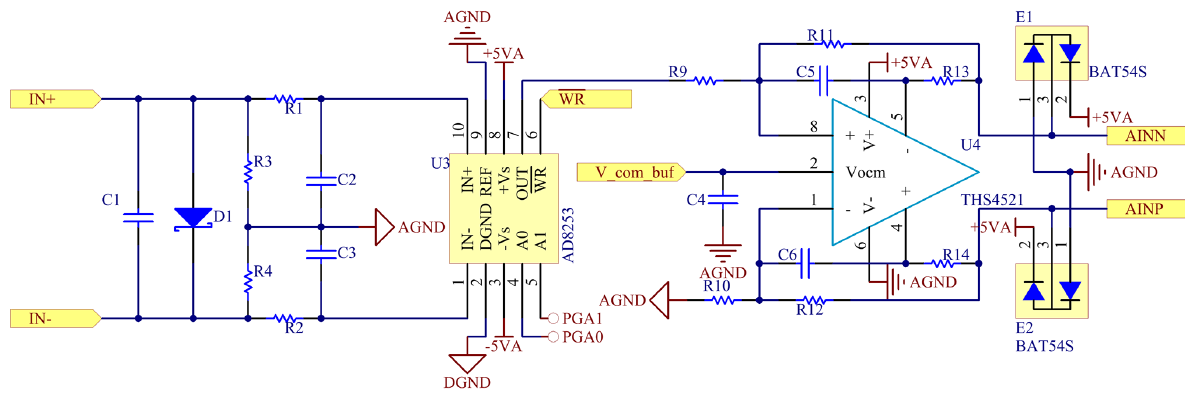
Figure 3. Schematic of the single channel of the acquisition